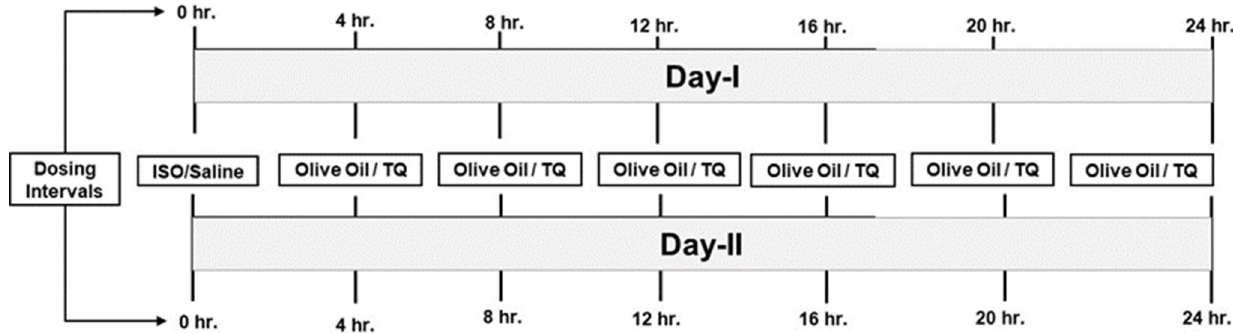
Figure 1. Treatment schedule. hr., hours; ISO, isoproterenol; TQ,